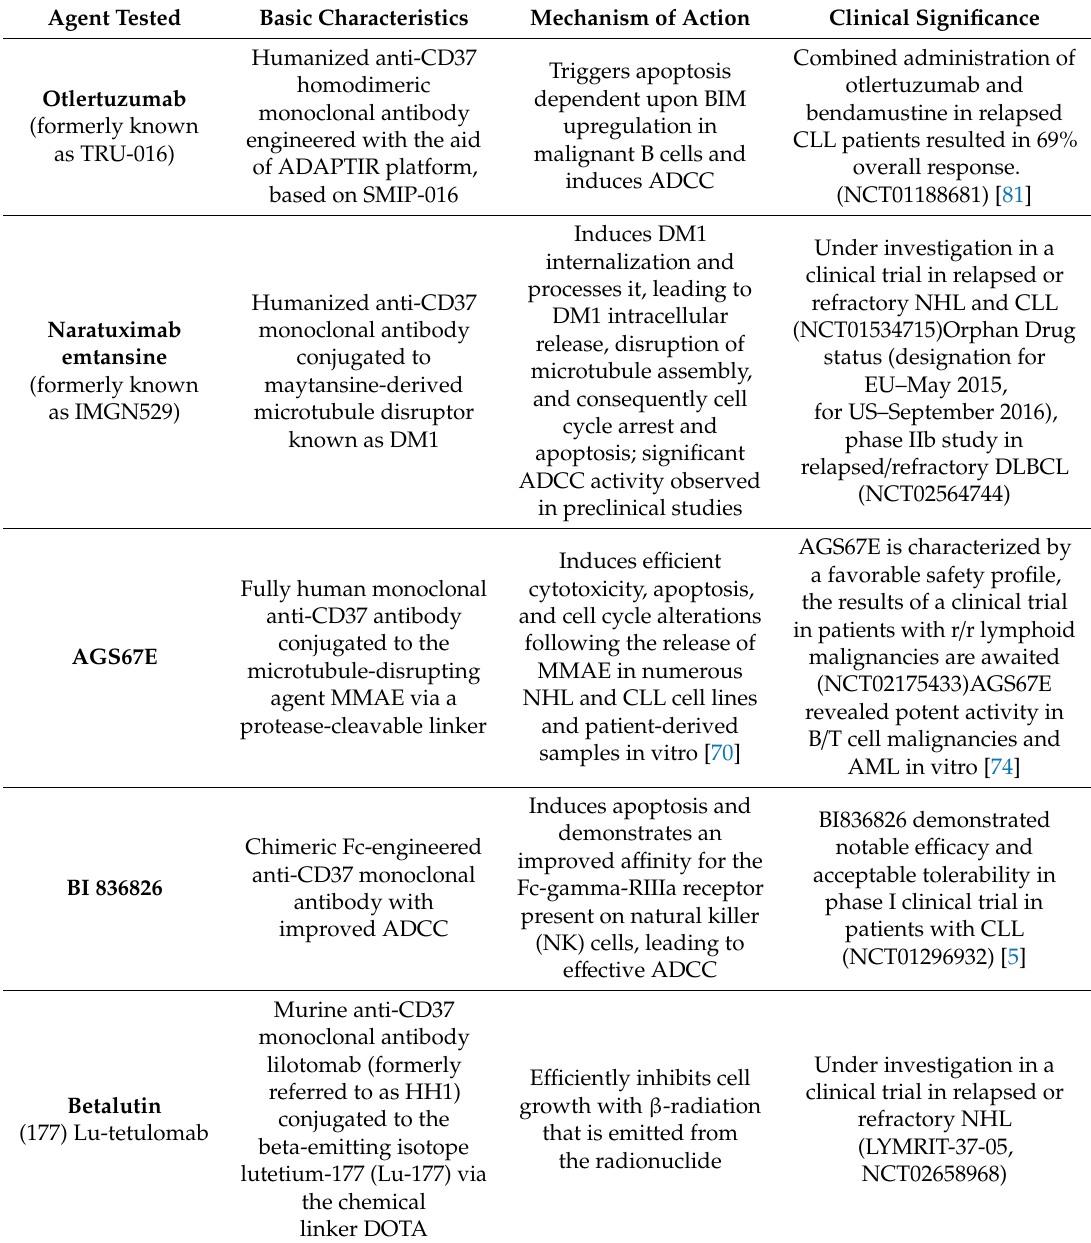
Table 1. Main characteristics of anti-CD37 directed